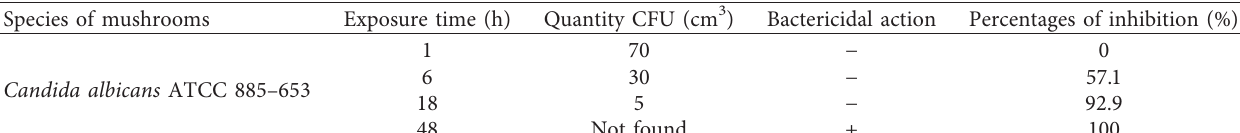
Table 3: Fungicidal properties of colloidal solutions of silver nanoparticles synthesized by the sonoelectrochemical method and stabilized with rhamnolipid solution.